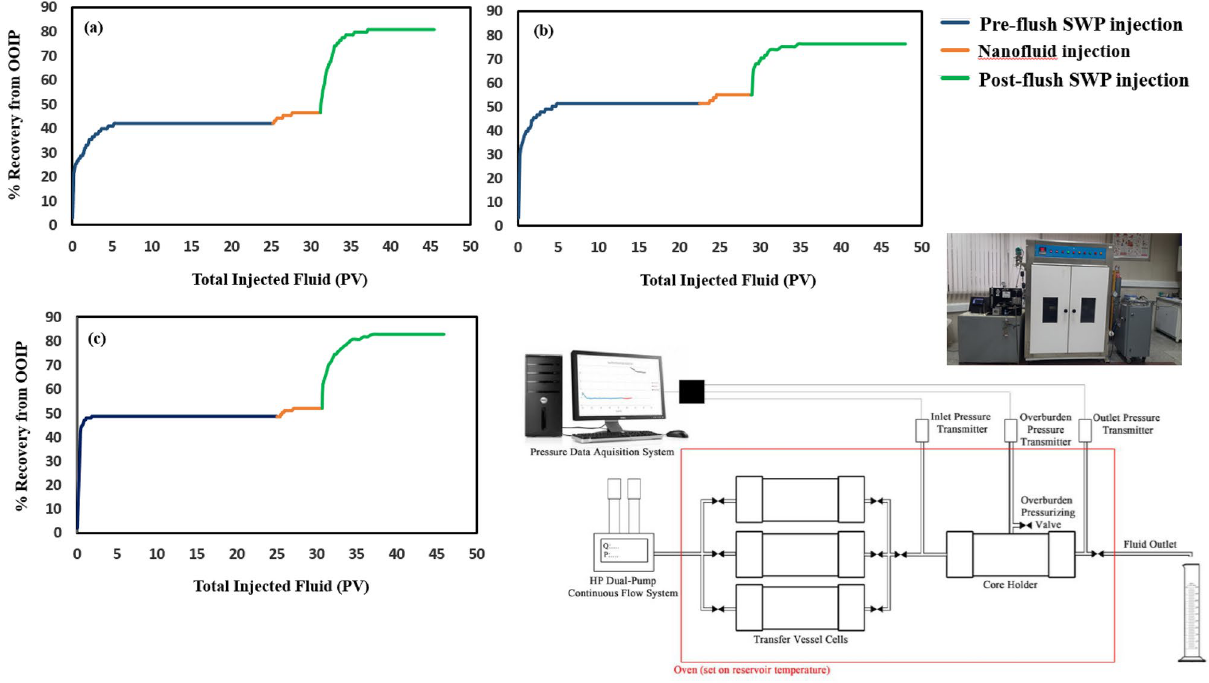
Figure 4. Oil recovery performance vs. injected PV of the core plugs at 90 °C, 750 psi and retention time of 72 h ( a ) core D, SWP/500-PE-cit-ANPs nanofluid/retention time/SWP injection scenario ( b ) core E, SWP/500- PE-cit-AQDs nanofluid/retention time/SWP injection scenario ( c ) core F, SWP/1000-PE-cit-AQDs nanofluid/ retention time/SWP injection